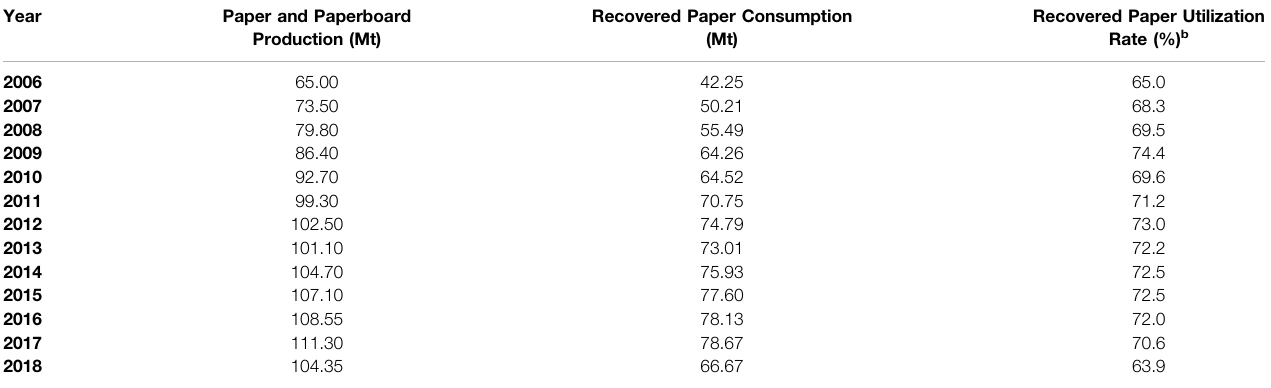
TABLE 4 | Utilization of recycled paper in China from 2006 to 2018 a . Paper and Paperboard Production